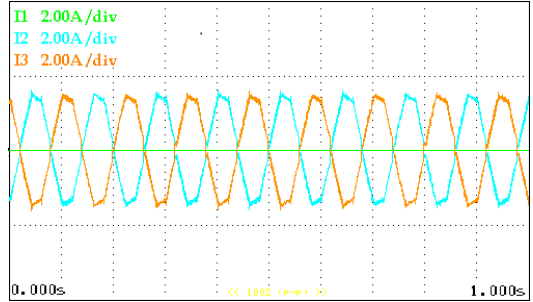
Figure 14. Currents in the BLDC motor operating under phase fault condition with current reduc- tion strategy.